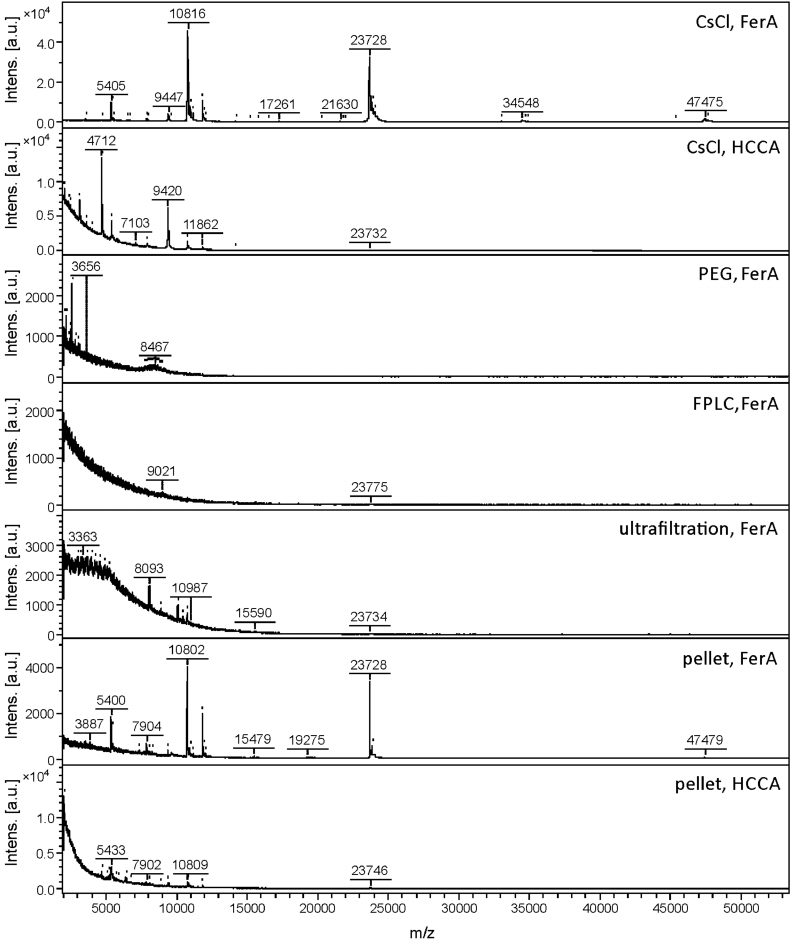
Figure 1. Comparison of the mass spectra of phage 77 prepared by five different sample preparation methods and by using two different matrix-assisted laser desorption ionization matrices, ferulic acid (FerA) and alpha-cyano-4-hydroxycinnamic acid (HCCA) shown for samples prepared by CsCl density gradient centrifugation and pellet